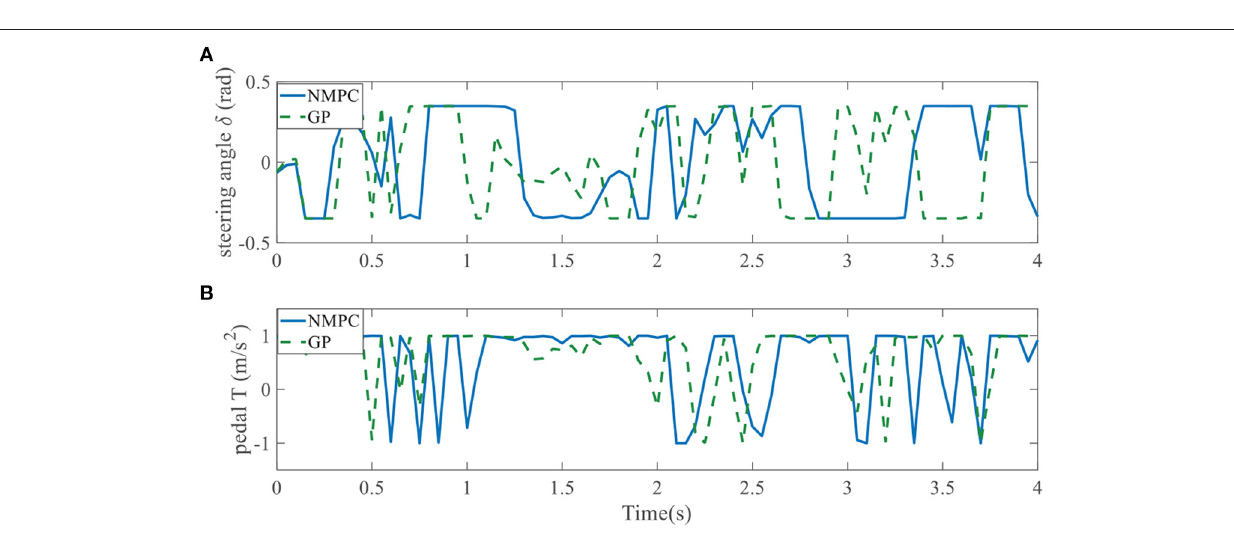
FIGURE 20 | Control inputs using NMPC and GPMPC for right overtaking. (A) Steering angle; (B)